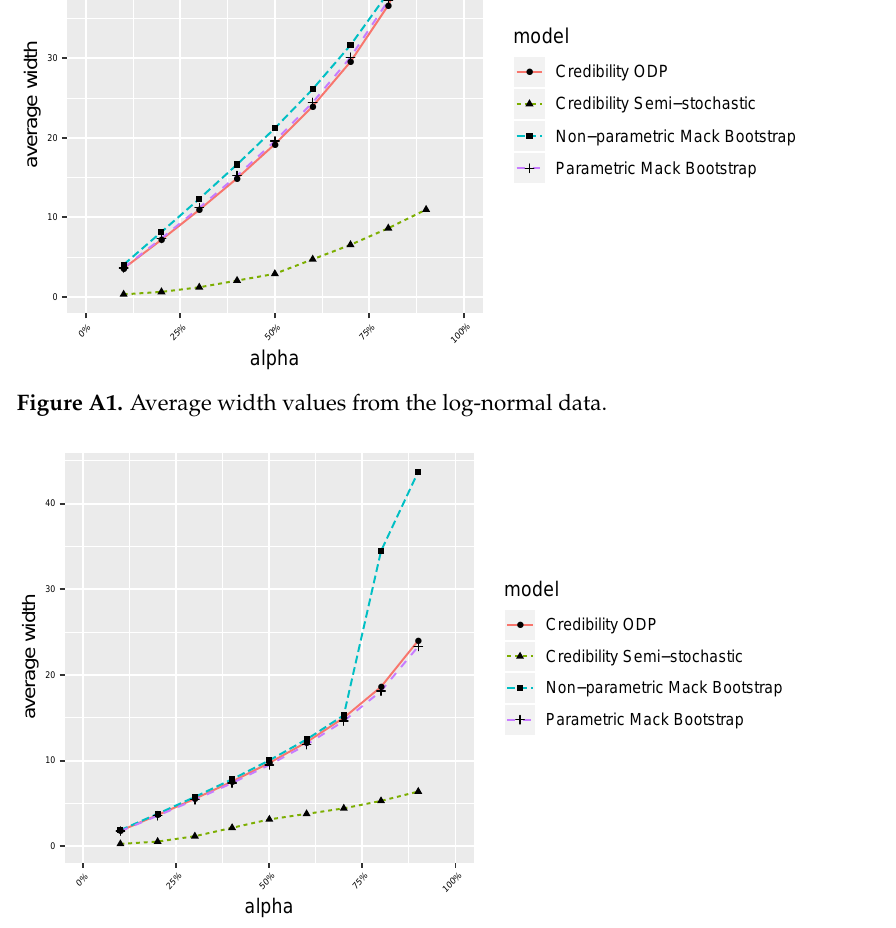
Figure A2. Average width values from the gamma